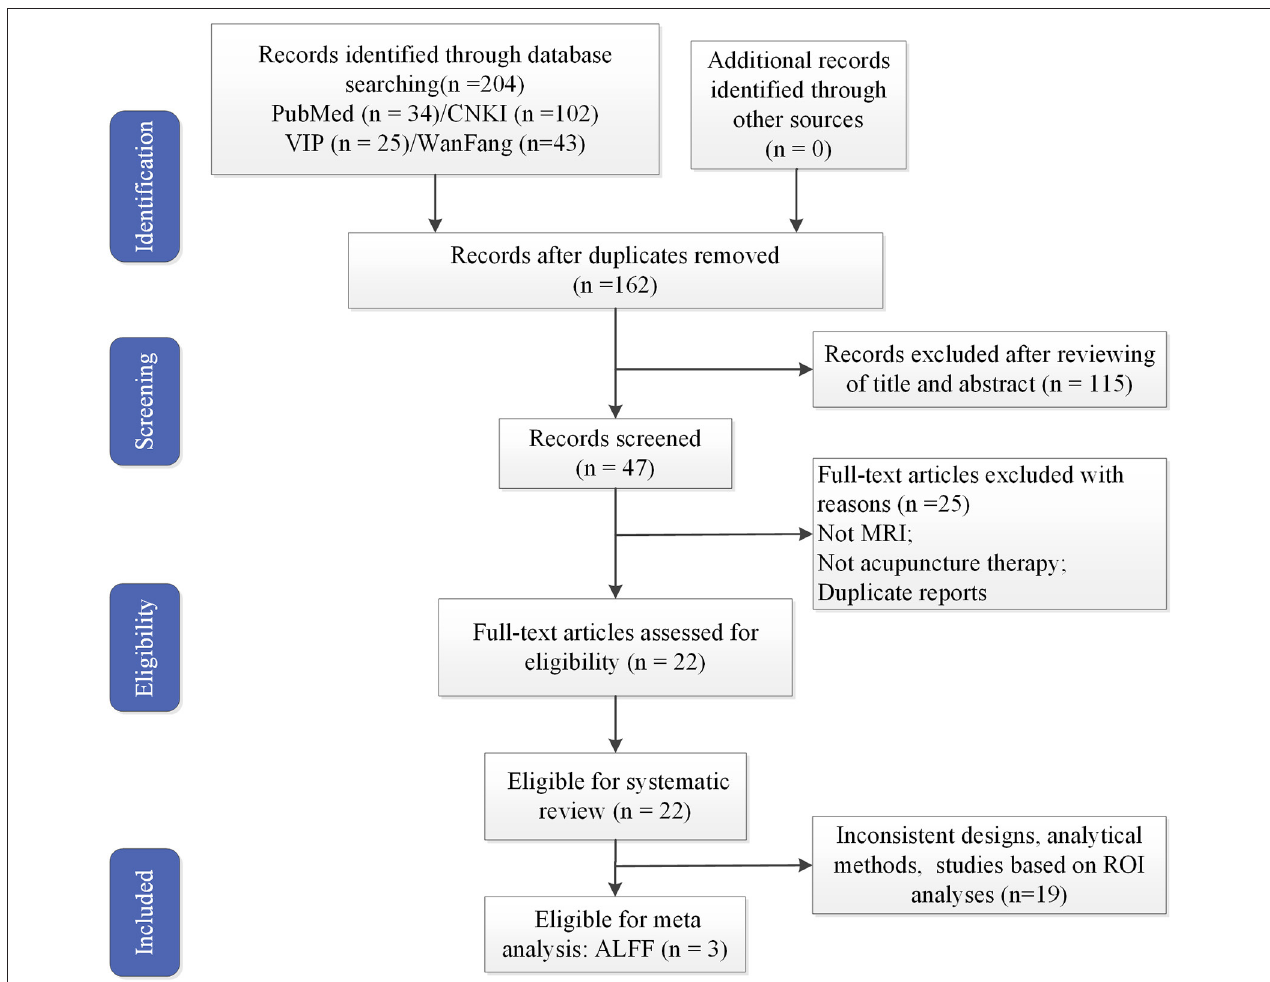
FIGURE 1 | Flowchart of literature selection. MRI, magnetic resonance imaging; ALFF, amplitude of low-frequency